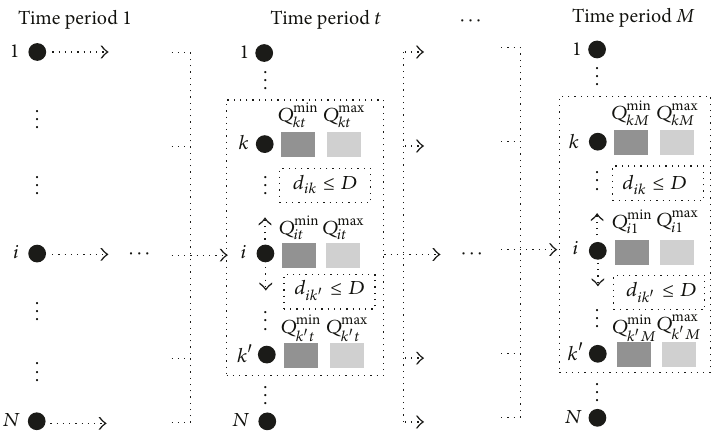
Figure 1: Dynamic working service network with dual